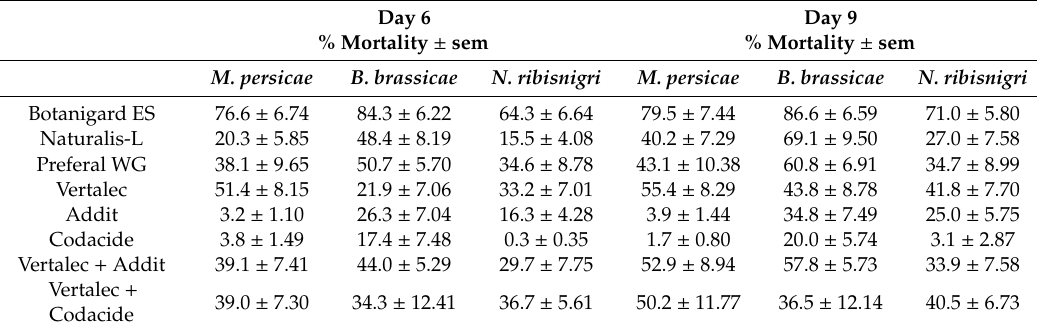
Table 4. Susceptibility of three aphid species to entomopathogenic fungi (EPF) biopesticides in a laboratory bioassay. The data show the mean % mortality recorded at day 6 and day 9 after treatment ( ± the standard error of the